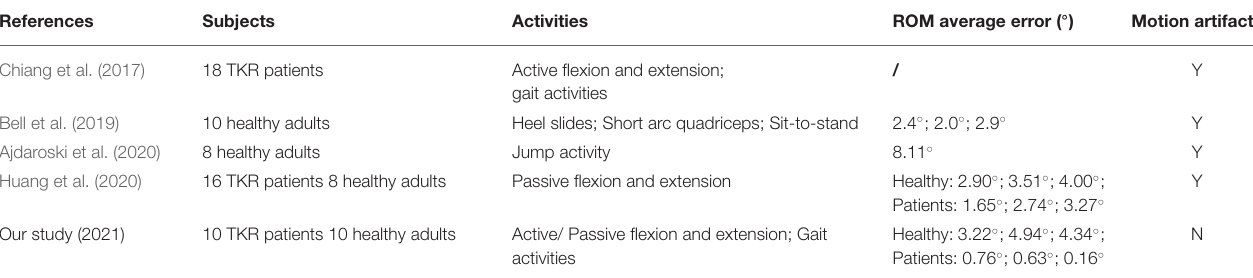
TABLE 3 | The comparison of state-of-art on knee ROM